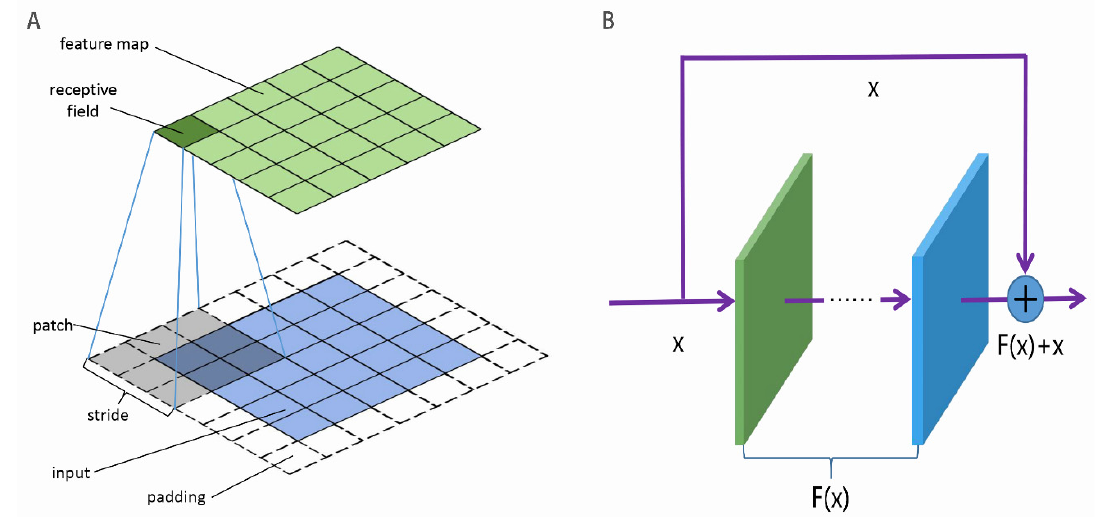
Figure 2. Illustration of ( A ) convolutions in the CNN and ( B ) the ResNet unit. F(x) generally is CNN.